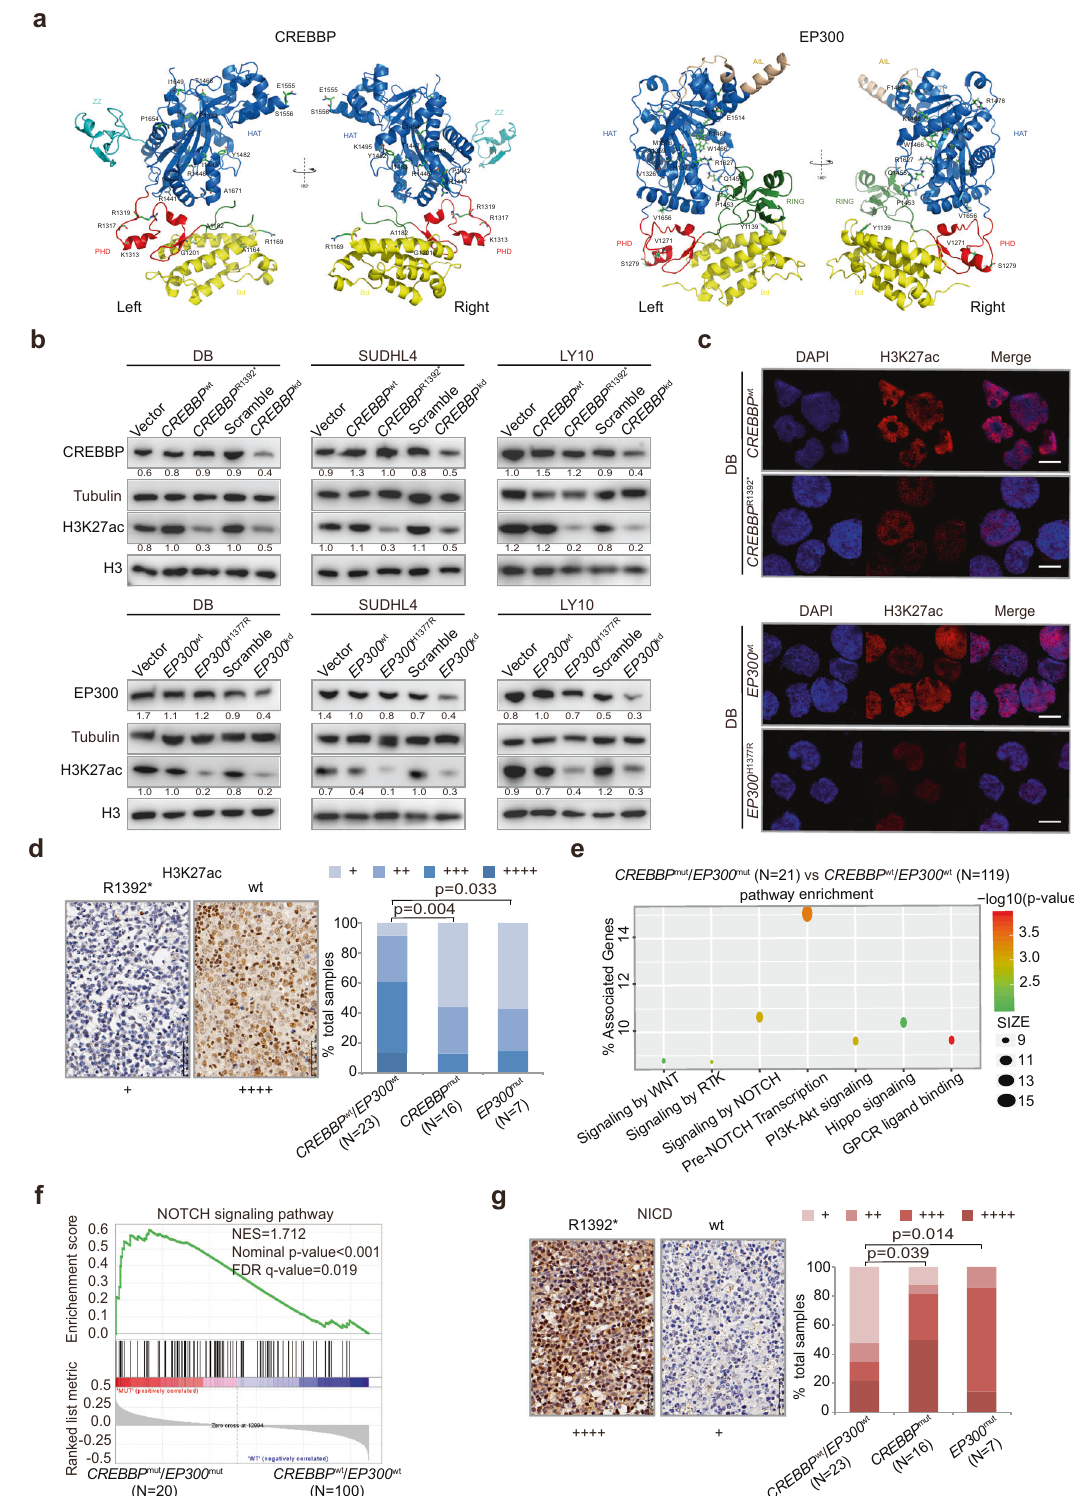
Signal Transduction and Targeted Therapy (2021)